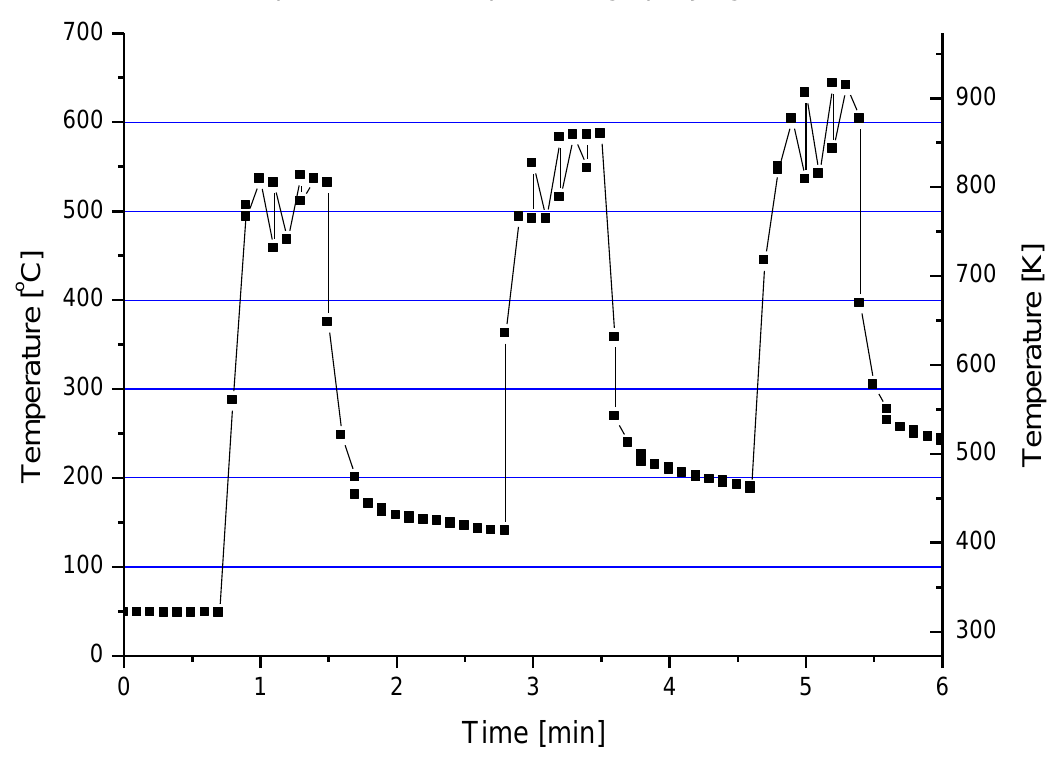
Figure 18. Evolution of a typical surface temperature during HA coating deposition